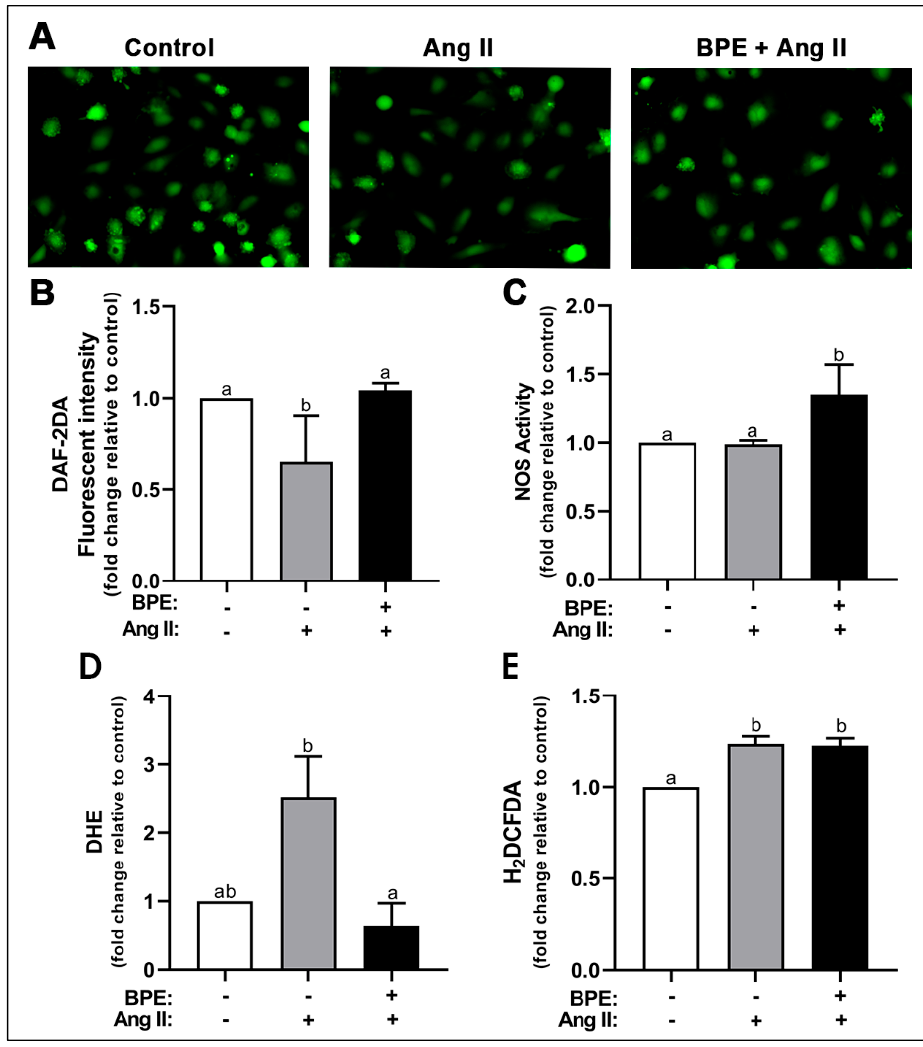
Figure 1. Blueberry polyphenol extract (BPE) prevents the decrease in nitric oxide (NO) levels and the increase in superoxide production induced by angiotensin (Ang) II in human aortic endothelial cells (HAECs). HAECs were treated with 200 µg/mL of BPE for 1 h then treated with 200 nM of Ang II for 12 h. NO levels were visualized ( A ) and quantified ( B ) after 30 min incubation with DAF-2DA. NO synthase (NOS) activity ( C ). ROS levels were determined after 30 min incubation with DHE ( D ) or H 2 DCFDA ( E ). Data are expressed as mean ± SD from three independent experiments. Values that do not share the same letter are significantly different from each other ( p ≤ 0.05).